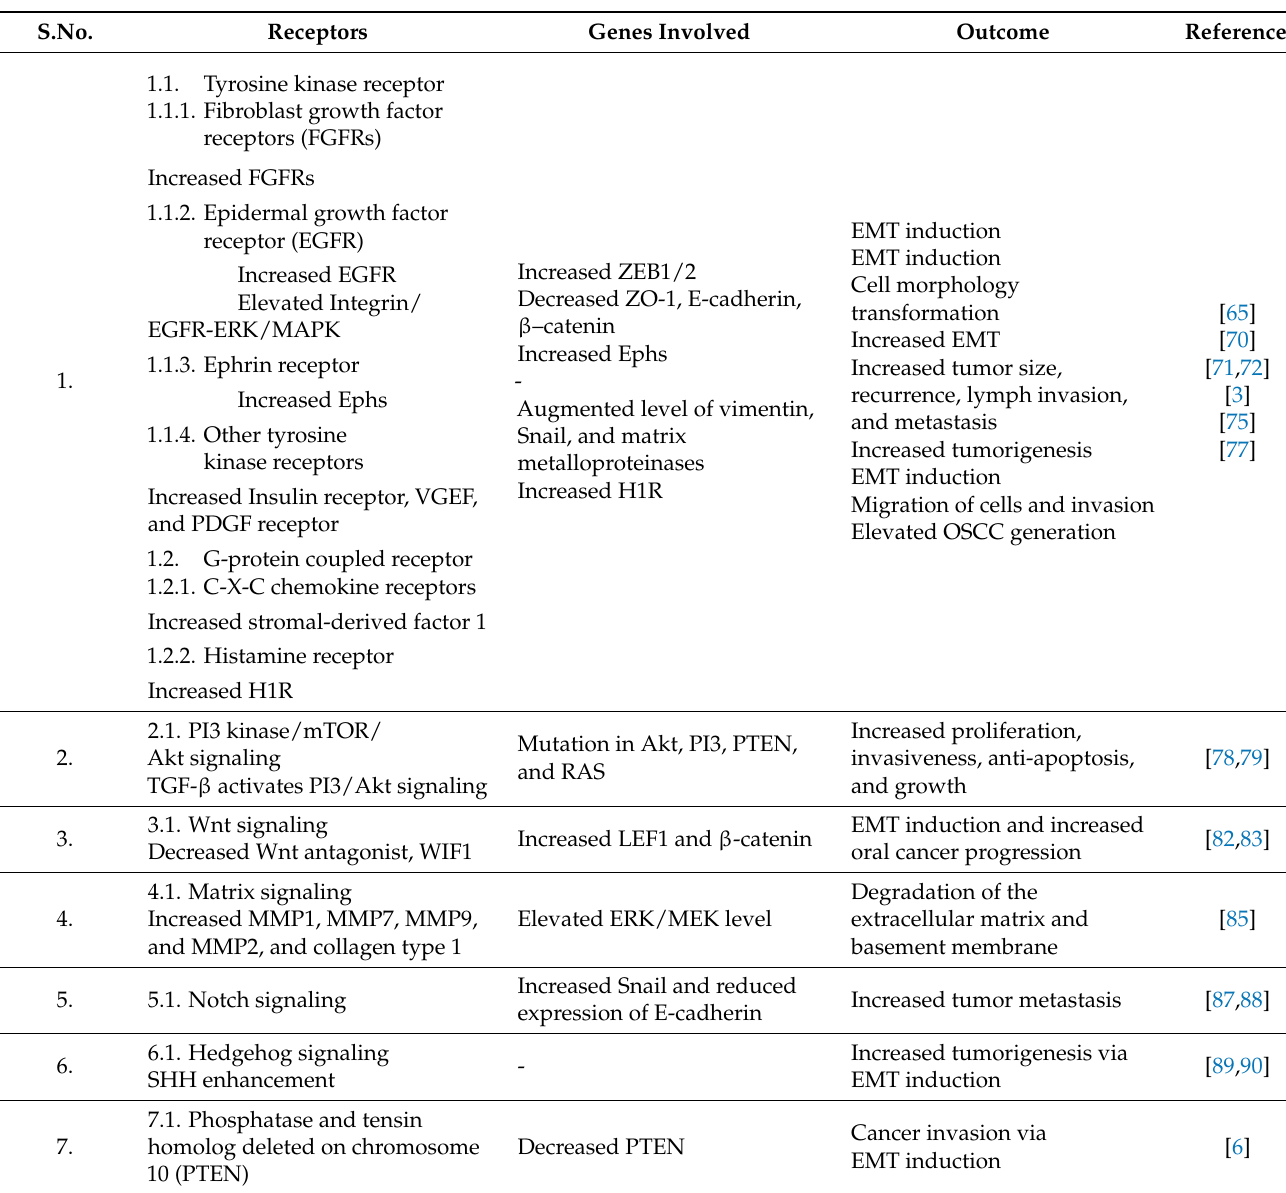
Table 3. Receptors induced by EMT during oral cancer